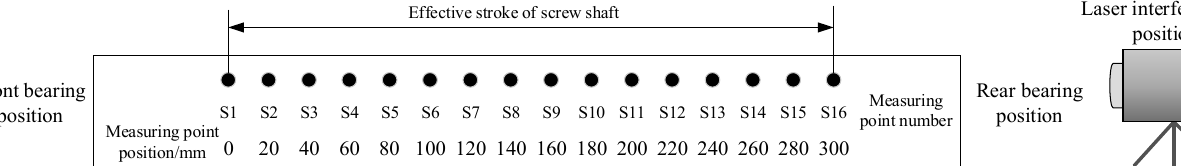
Figure 3. Distribution of measuring points. Table 3. Experimental parameters.